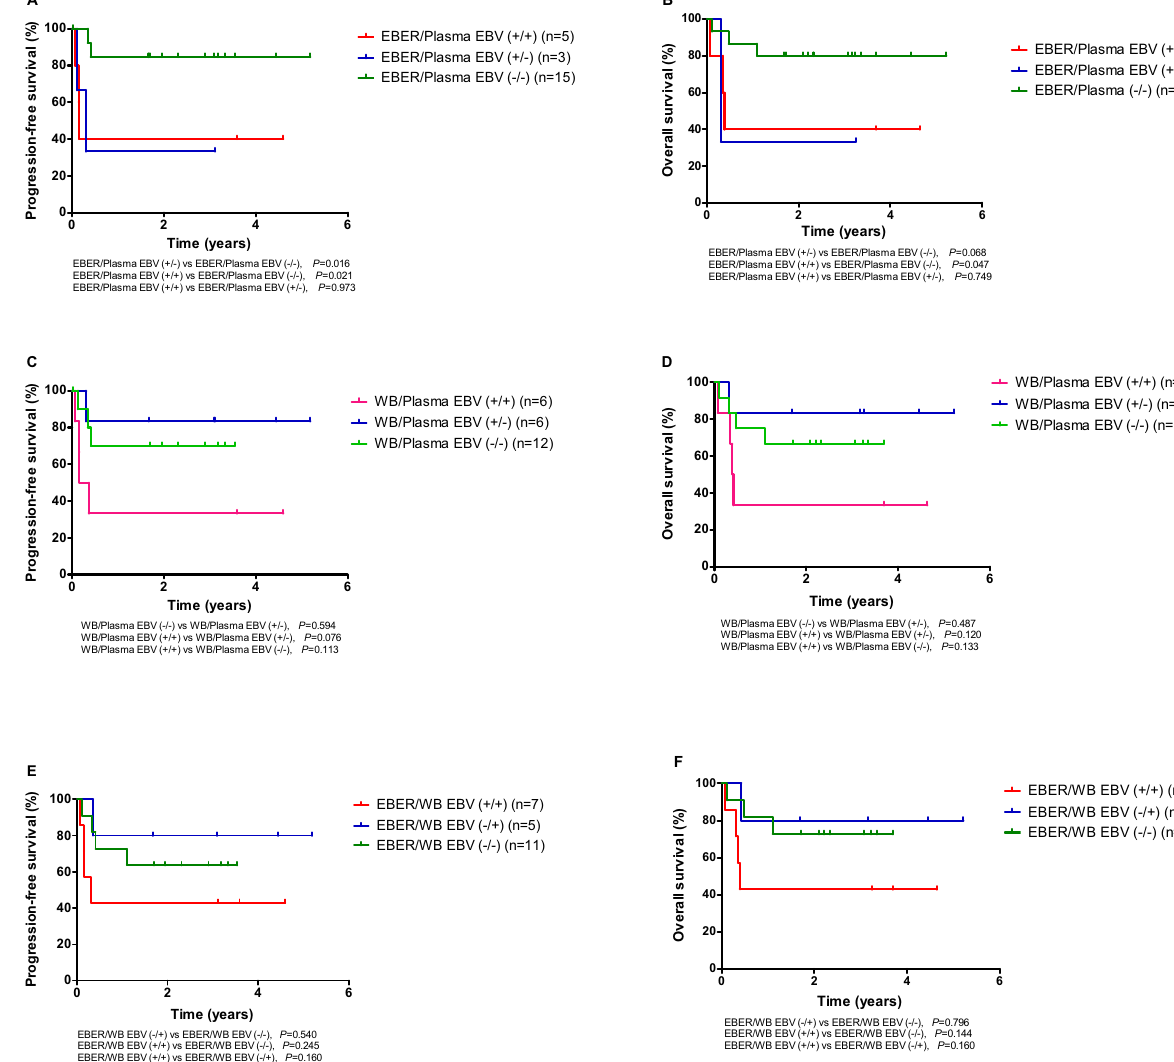
Figure 3. Progression-free survival and overall survival according to the pre-treatment EBER, whole blood EBV, or plasma EBV status in patients with results from all three tests (n = 24). EBER Epstein-Barr virus- encoded small ribonucleic acids, WB whole blood, EBV Epstein-Barr virus. *There was no patient with WB/ plasma EBV (−/ +). In addition, there was only one patient each with EBER/plasma EBV (−/ +) or EBER/WB EBV (+ /−), and were excluded from this